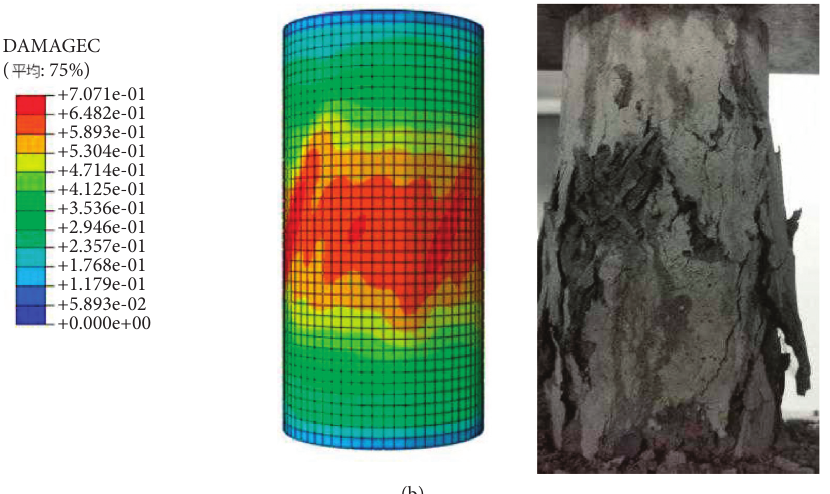
Figure 34: Comparison diagram between test and modeling. (a) Comparison diagram in applied load. (b) Comparison diagram after loading.